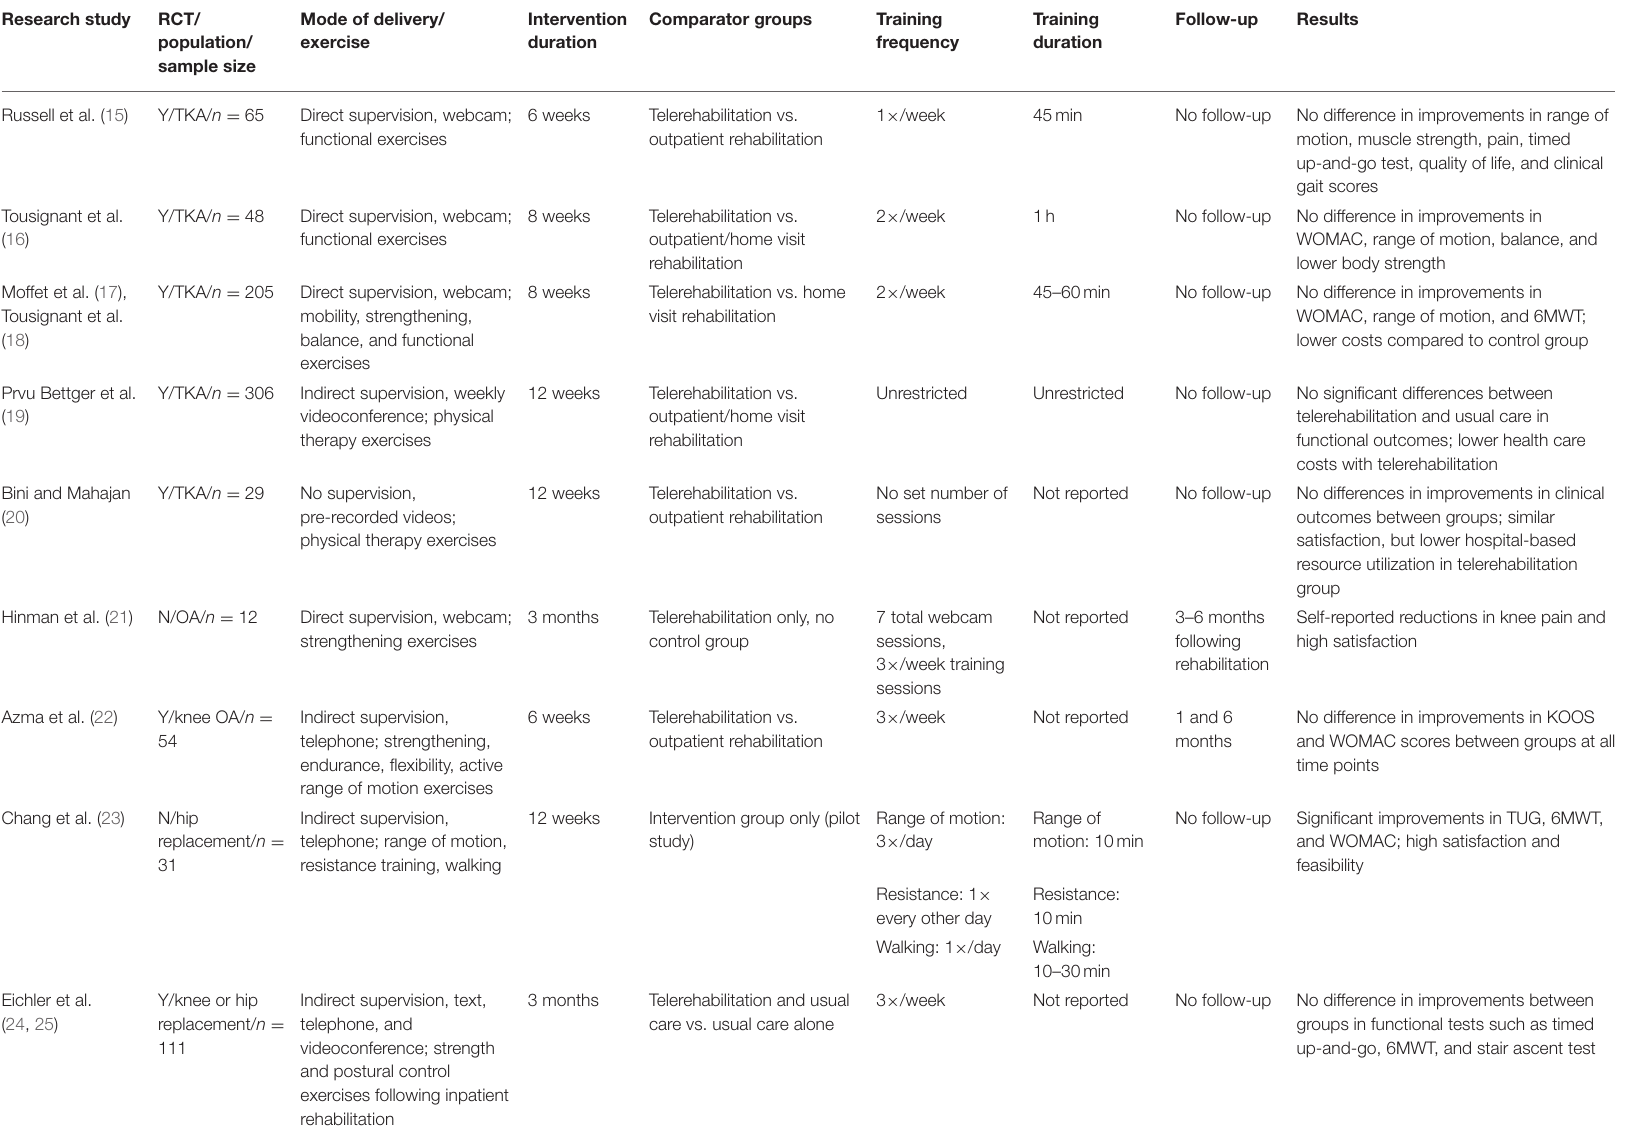
TABLE 1 | Characteristics and outcomes of home-based tele-exercise studies—musculoskeletal system. Research